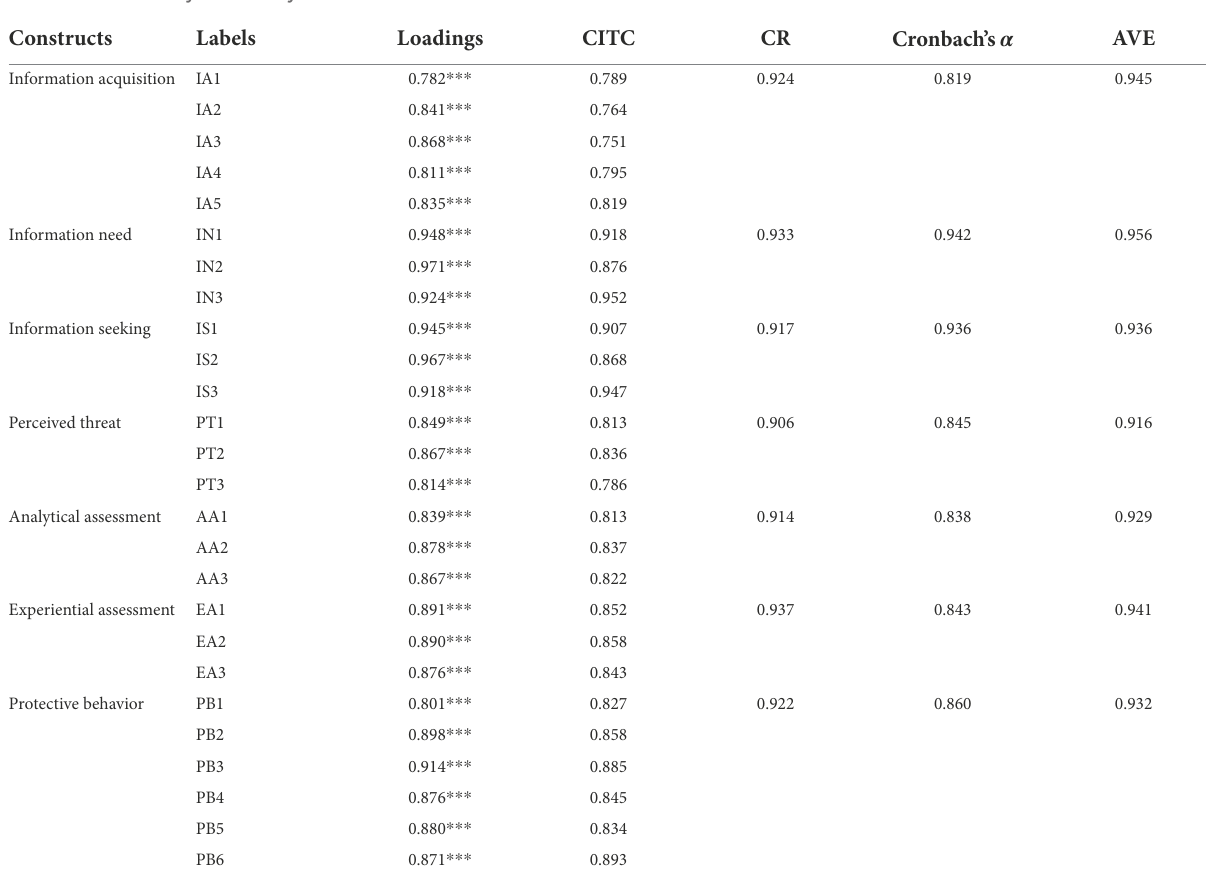
TABLE 4 Confirmatory factor analysis results for measurement